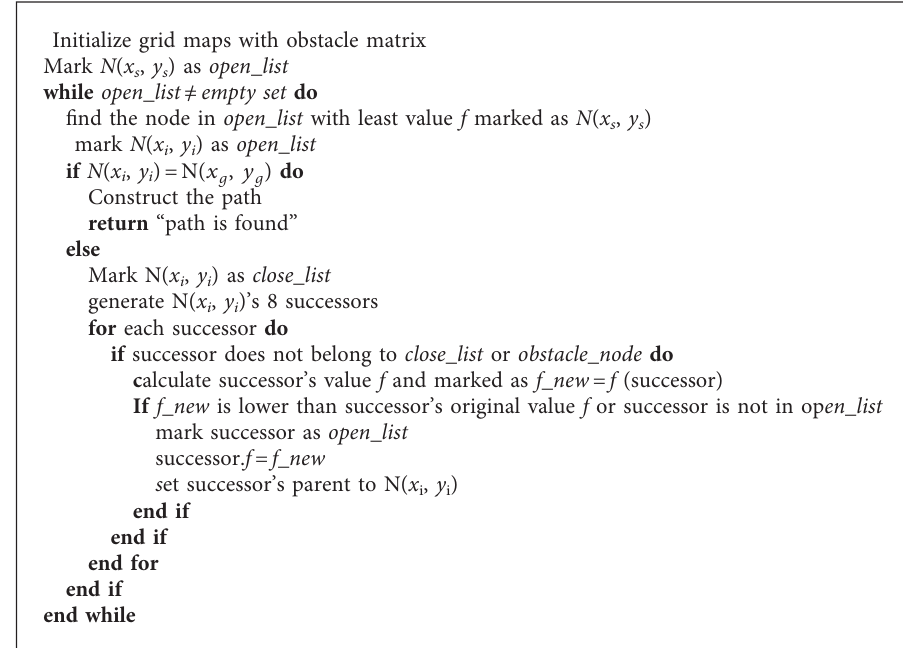
Initialize grid maps with obstacle